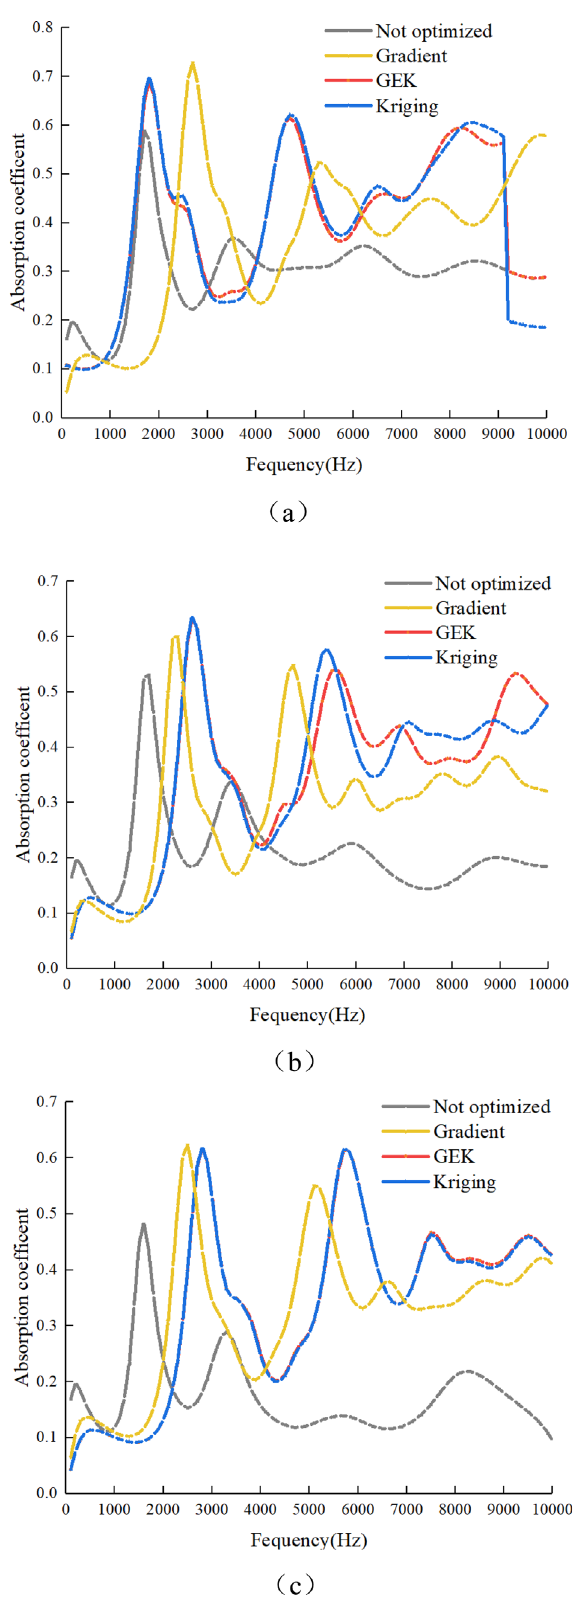
Figure 12. Sound absorption coef fi cients of different optimiza- tion models at different pressures. (a) 1 MPa; (b) 2 MPa; (c) 3